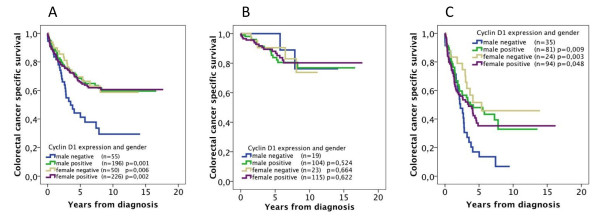
Kaplan-Meier estimates of colorectal cancer-specific survival according to combinations of gender and positive versus negative cyclin D1 expression. Colorectal cancer-specific survival in (A) all patients, (B) patients with stage I-II disease and (C) patients with stage III-IV disease. Log-rank P values correspond to pairwise comparisons of cyclin D1-negative tumors in male patients with the other strata, respectively.